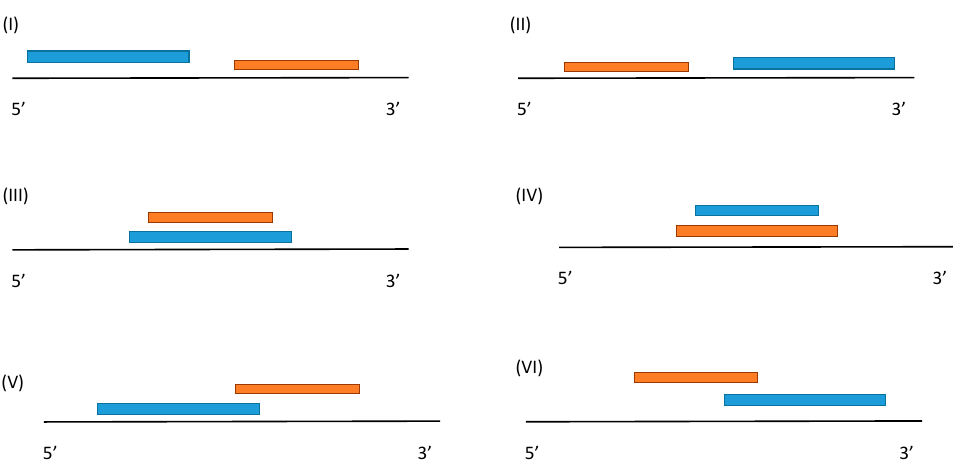
Figure 2. Possible location of two neighboring TFBSs. The first TFBS is marked blue; the second is marked red. The black line is DNA, where the 5 ′ to 3 ′ direction of strand DNA is called the leading strand. ( I , II ) cases where two TFBS are located in the promoter region that do not overlap, ( III , IV ) cases are where one TFBS can be embedded in the other, and ( V , VI ) cases are where one TFBS partially overlaps the other.